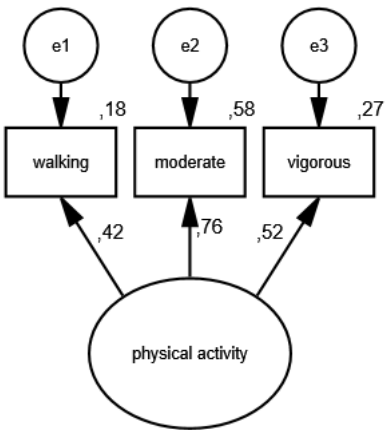
Figure 2. Standardized effects of the model of physical activity measurement in the group of men.